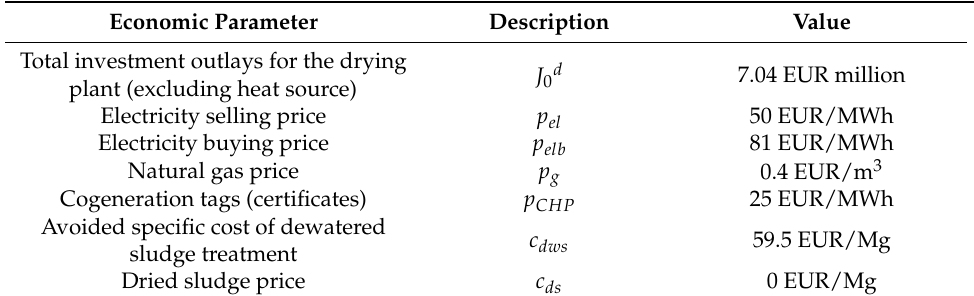
Table 4. Basis economic data used for the optimization analysis.